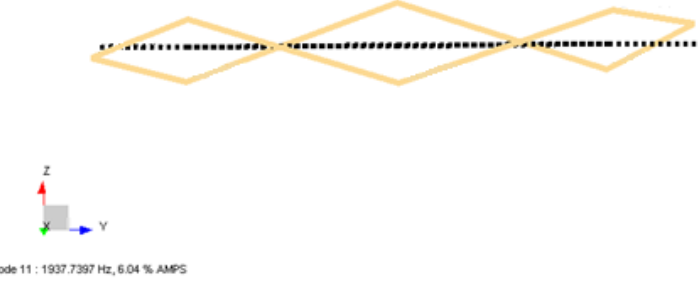
Figure 16. Third mode shape obtained from LMS Test Lab software for the Type-2 coil sample.